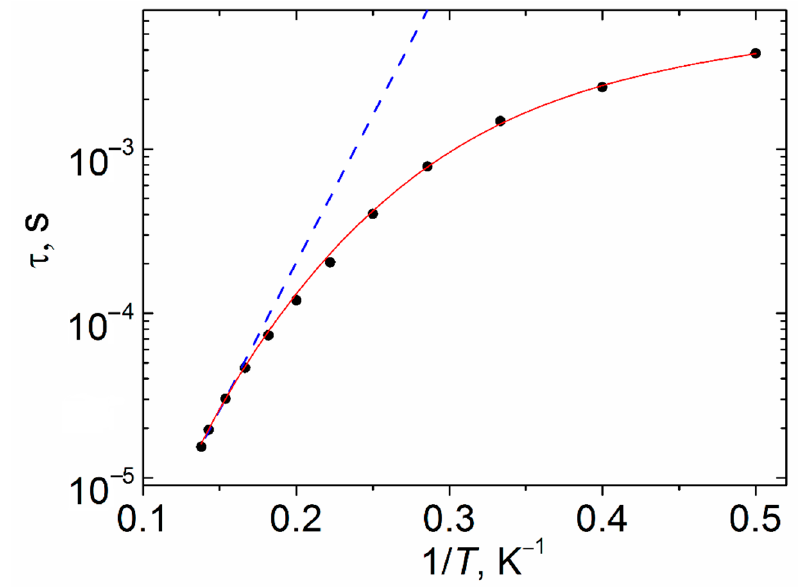
Figure 11. The τ vs. 1 / T plot for complex IX under 1500 Oe field at T = 2 K. Blue dashed line represents fitting by the Orbach mechanism (Arrhenius equation). Solid red line represents fitting by the sum of direct and Raman relaxation mechanisms.